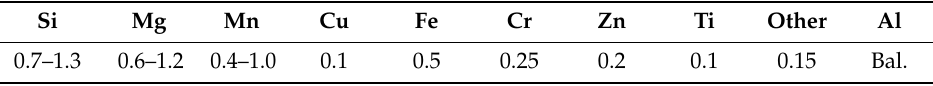
Table 1. Chemical composition and mechanical properties of AA6082T6 sheets.